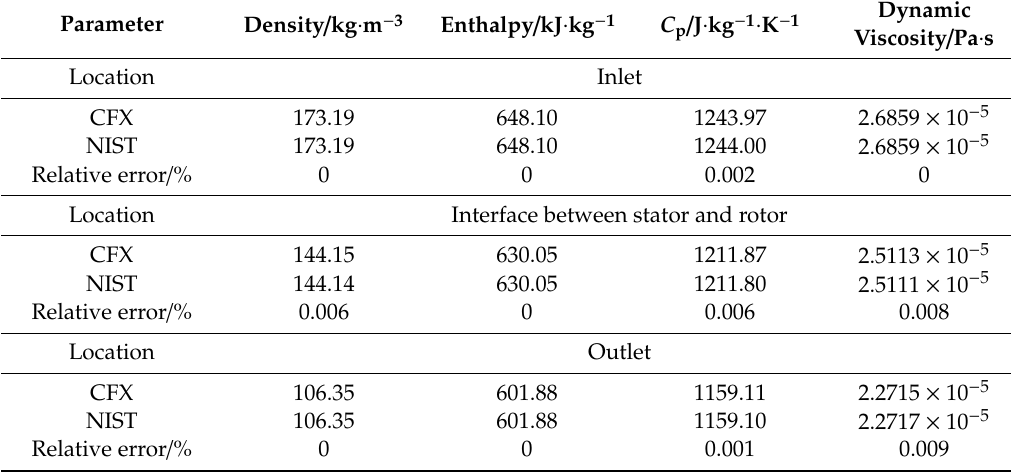
Table 4. Validation of SCO 2 fluid property.